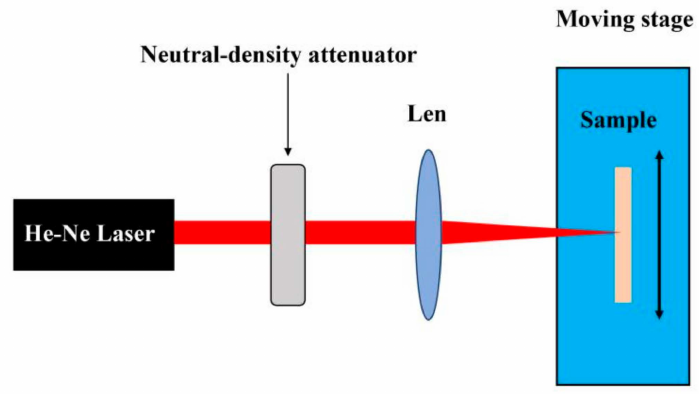
Figure 2. The simple experiment devices for making a line on the